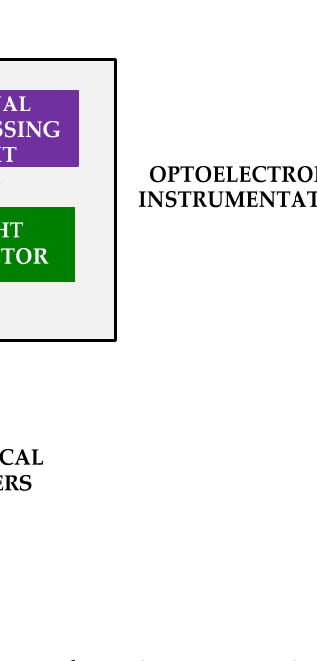
Figure 1. Typical components of an optoelectronic system associated with optical sensors. Here, X symbolizes the variable that modulates some parameters of the light.